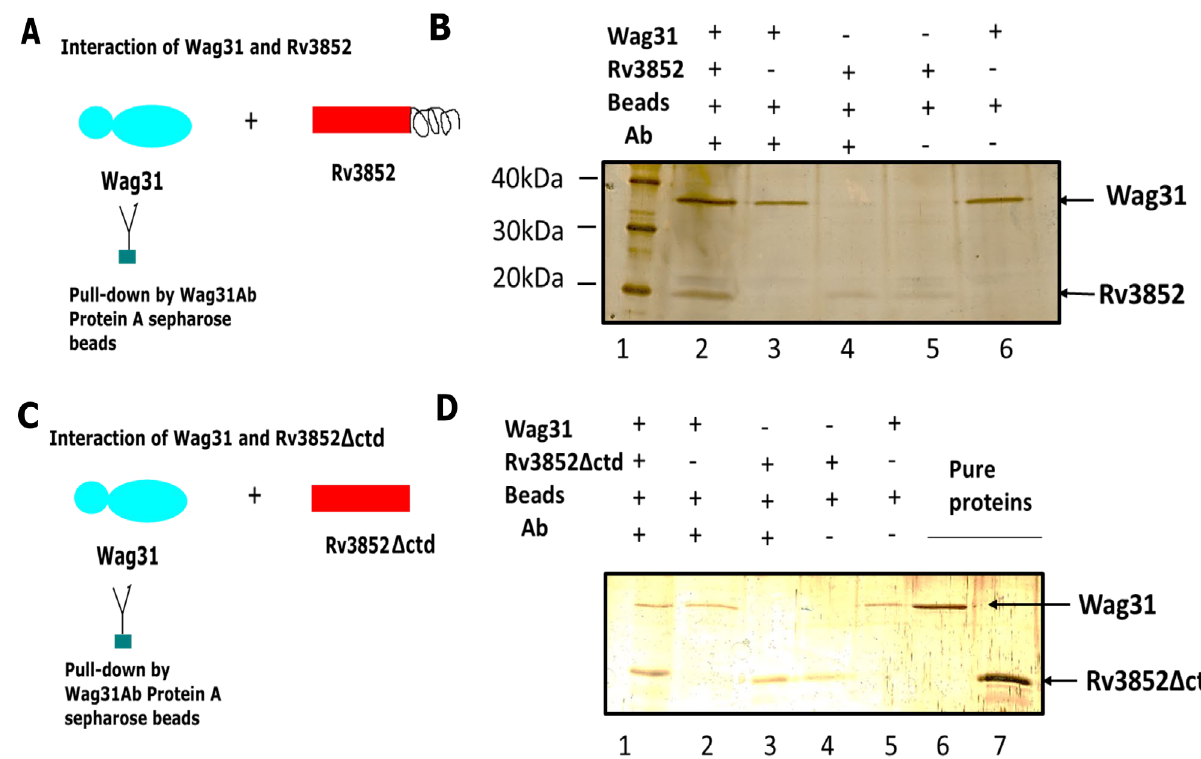
Figure 2. Direct physical interaction between Rv3852 and Wag31. The direct physical interaction was tested between Rv3852 and Wag31 by setting up reactions according to the scheme outlined in ( A ). ( B ) The silver-stained SDS-PAGE of pellet fraction obtained after pull-down with Wag31 antibody-coated beads. Immuno-precipitated Rv3852 is shown in the test lane (lane 2), and the positive (Wag31, Ab, beads), protein control, and bead controls for both the proteins are shown in lanes 3, 4, 5, and 6. ( C ) The interaction experiment between Wag31 and Rv3852 ∆ ctd was set up as shown. (D) SDS-PAGE showing interaction between Rv3852 ∆ ctd and Wag31. Immuno-precipitated Rv3852 ∆ ctd is shown in the test lane (lane 1). The positive, protein, and bead controls with both the proteins are shown in lanes 2, 3, 4, and 5. The pure proteins are shown in lanes 6 and 7. The contents of each reaction are shown on top of gels in (B) and (D).